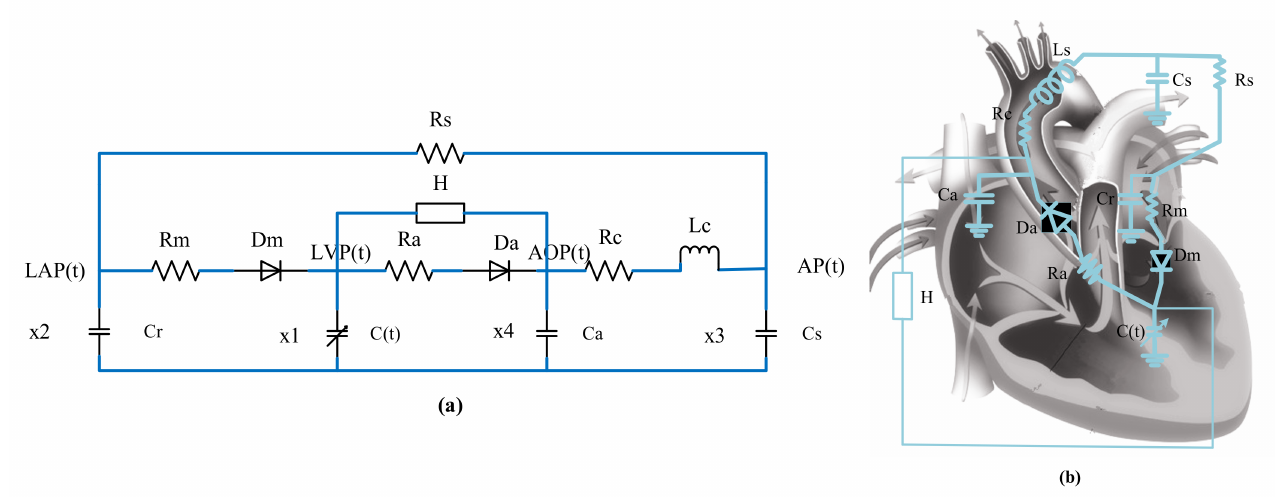
Figure 4. Updated electric circuit model. ( a ) 0D lumped-parameter model of parallel rotating blood pump for left ventricular assist, ( b ) Equivalent circuit of blood circulation.